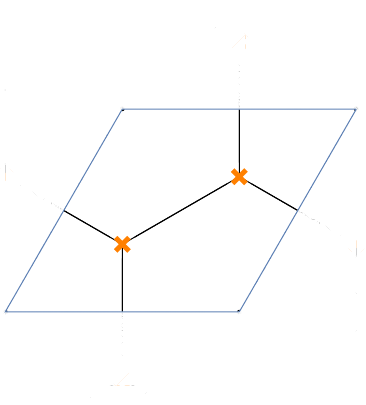
Figure 13. The BPS graph of the SU(2), N = 2 (cid:3) theory.